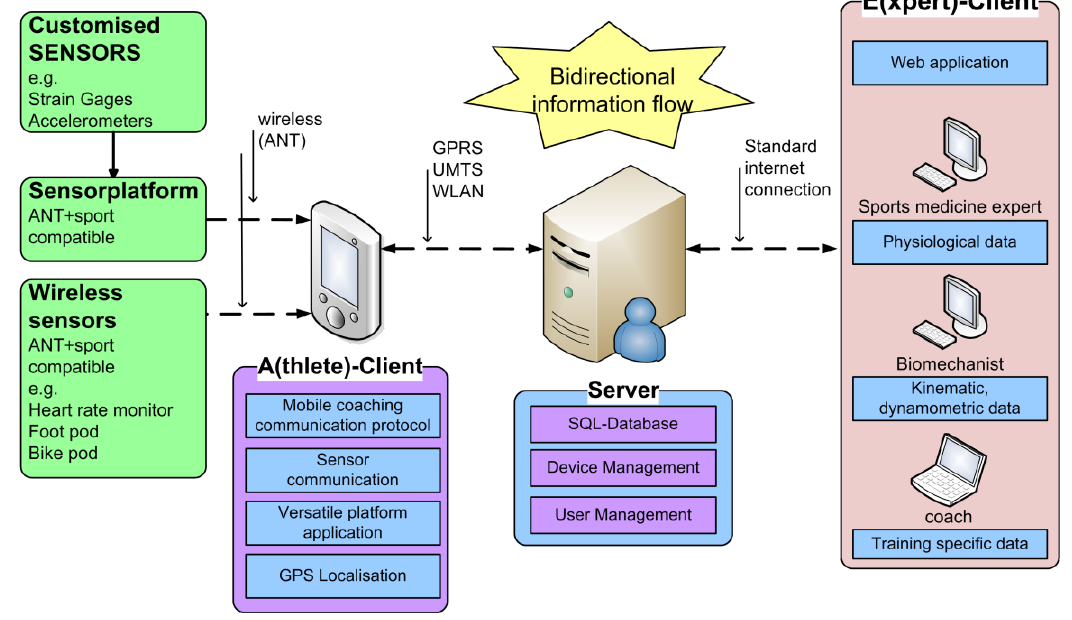
Figure 1. Overview of the Mobile Coaching System ( cf.